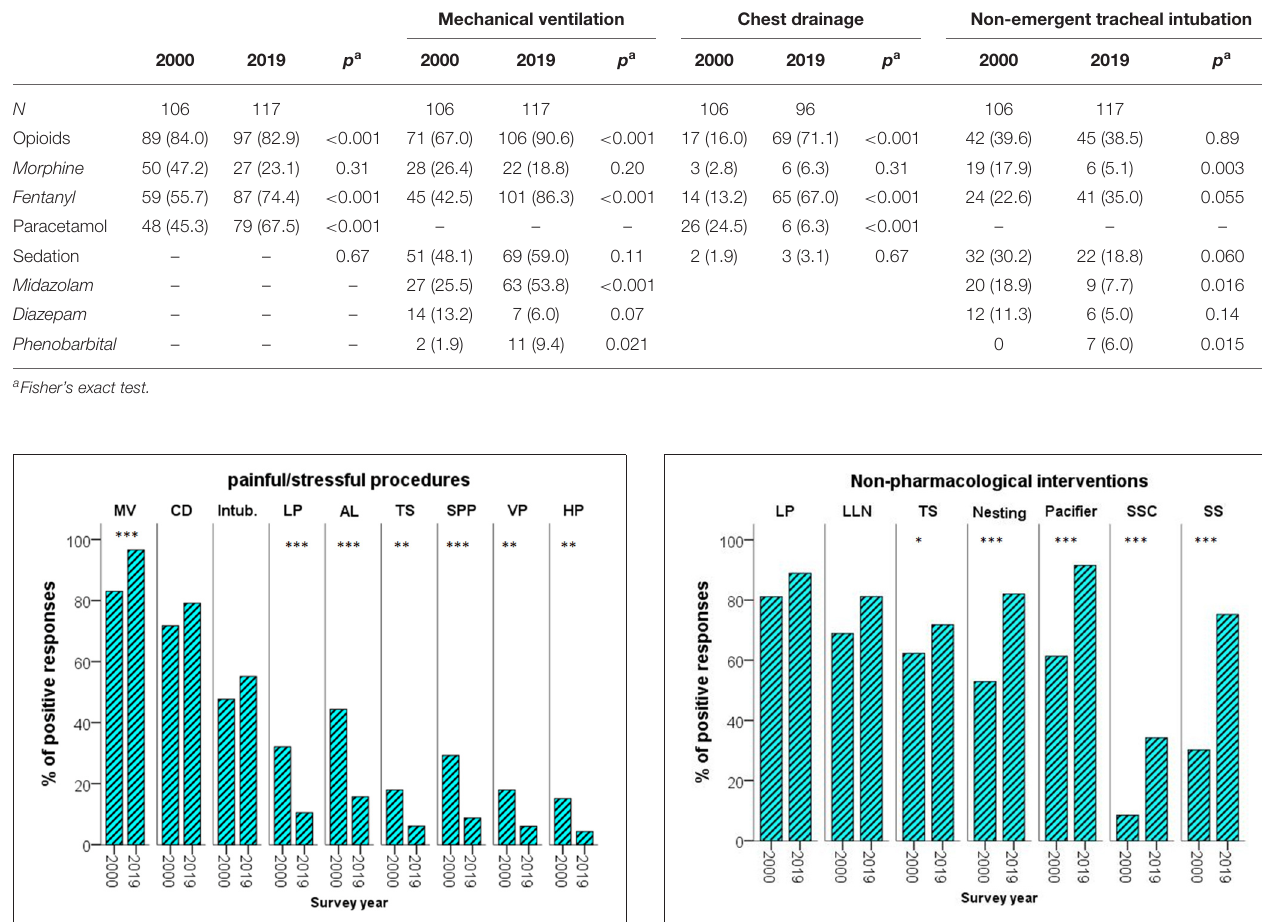
FIGURE 1 | Percentage of the respondents using analgesia—sedation prior to or during painful/stressful procedures, at the two time-points. AL, arterial line; CD, chest drainage; HP, heel prick; Intub., intubation; LP, lumbar puncture; MV, mechanical ventilation; SPP, suprapubic paracentesis; TS, tracheal suction; VP, venous puncture; ** p < 0.01; *** p < 0.001.